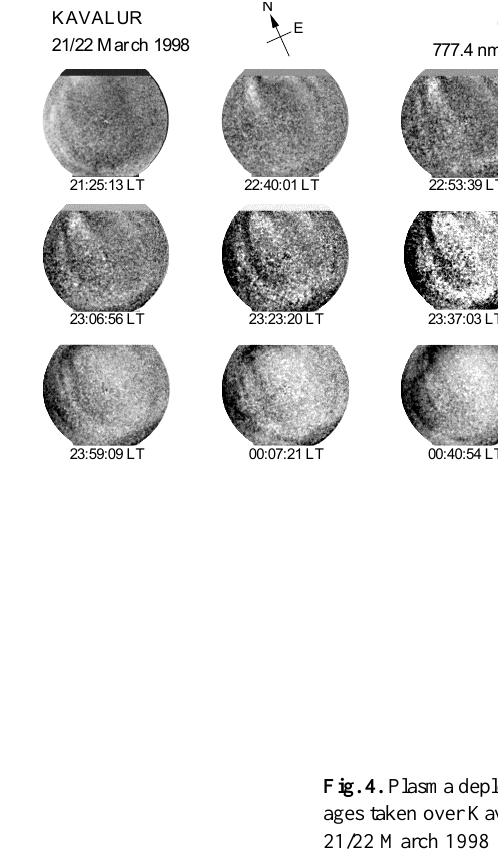
Fig. 4. Plasma depletions as seen in im- ages taken over Kavalur on the night of 21/22 March 1998 (a) at 630nm, (b) at 557.7nm and (c) at 777.4nm. Times written below images represent local time in hrs, min and s. The arrow points towards the geomagnetic